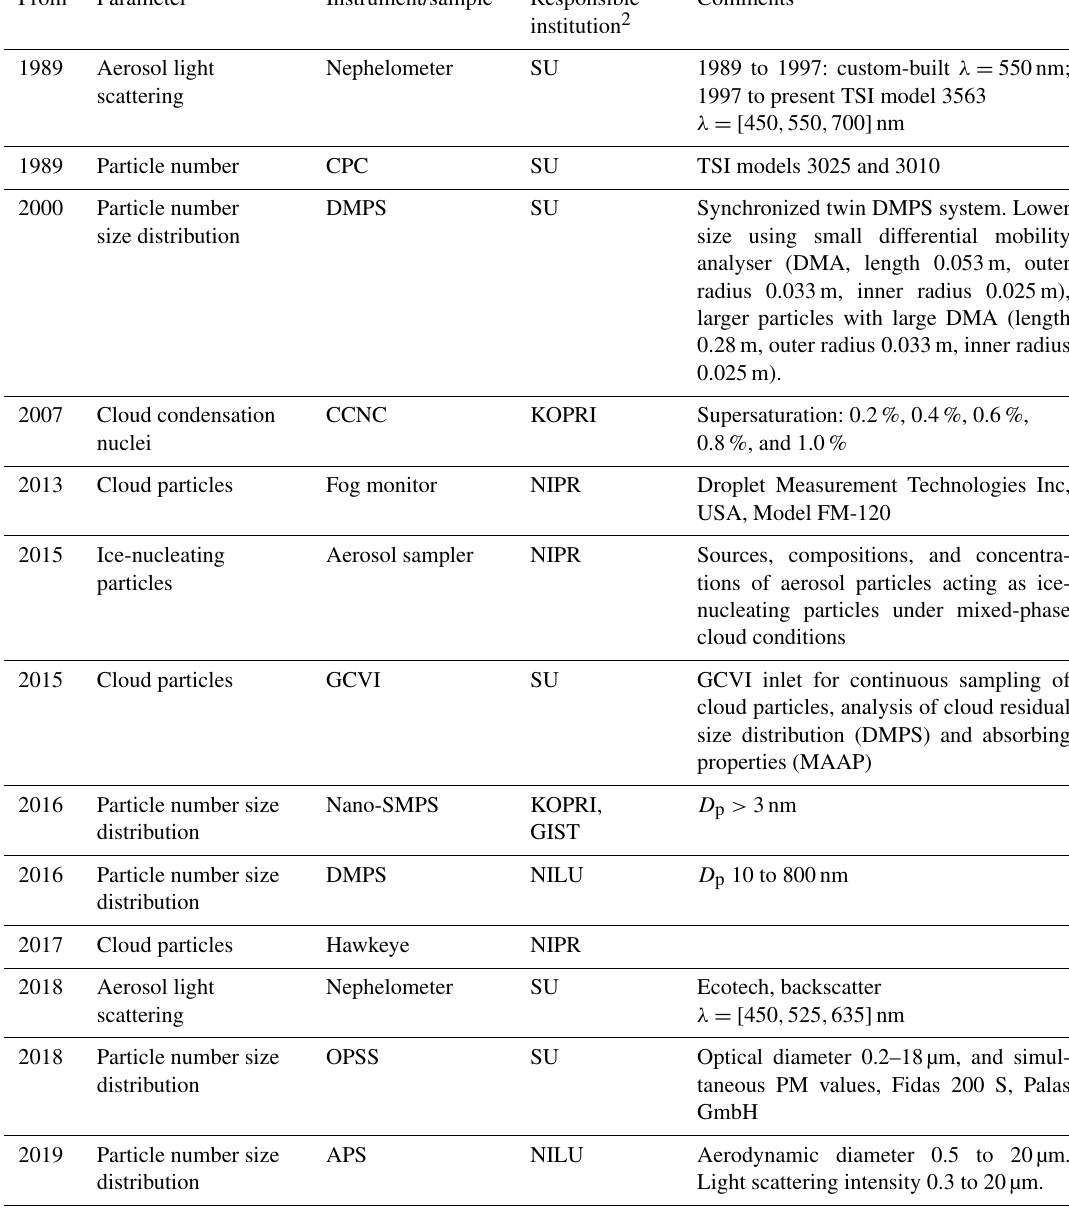
Table 2. Aerosol physical property measurements at the Zeppelin Observatory and measurement owner (institute), listed chronologically by measurement starting year. See table footnotes for full lists of